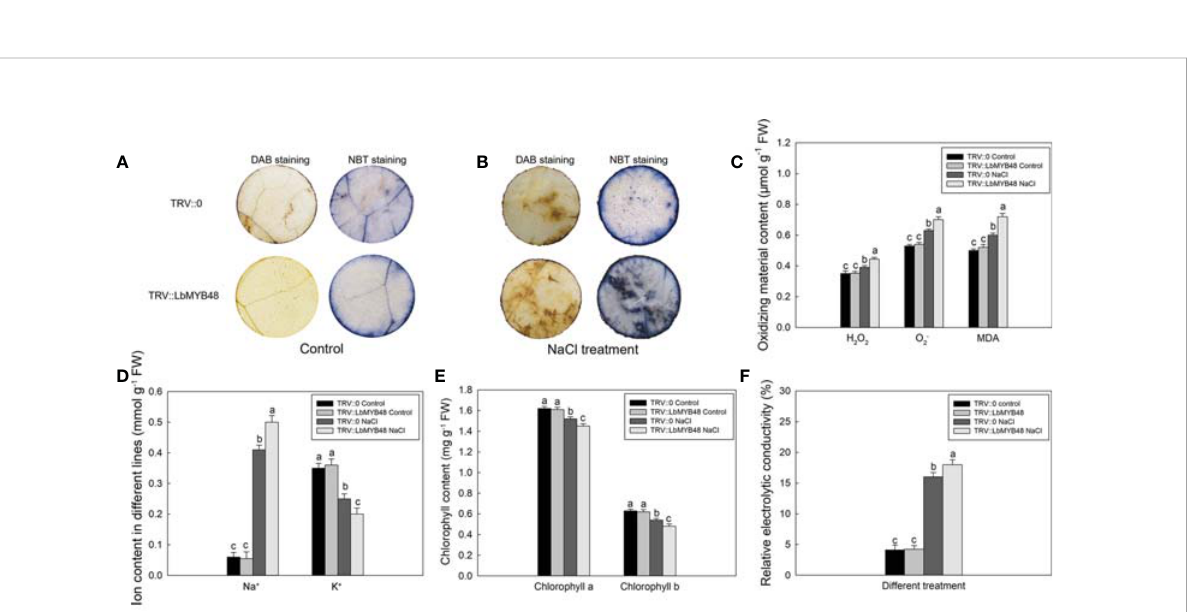
FIGURE 4 Analysis of salt tolerance capacity of LbMYB48 silenced lines. (A) DAB and NBT staining results of leaf discs from the TRV :: LbMYB48 and TRV:: 0 lines under normal growth conditions; (B) DAB and NBT staining results of leaf discs from the TRV :: LbMYB48 and TRV:: 0 lines under